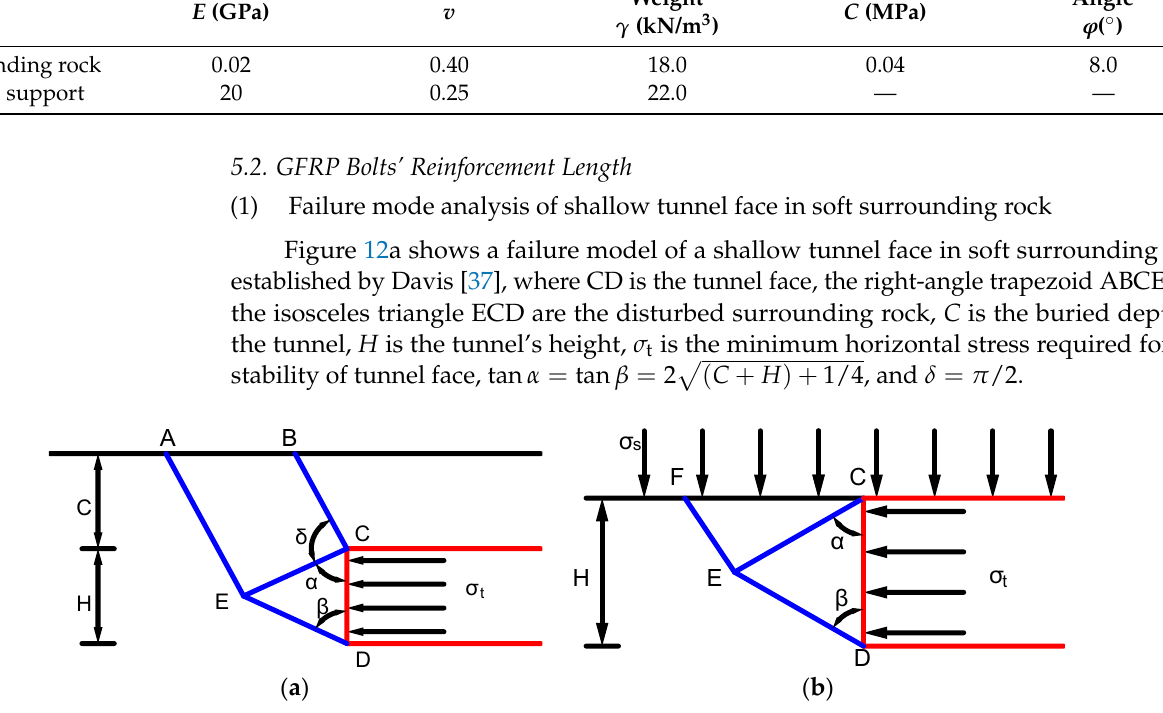
Figure 12. Failure model of shallow tunnel face in soft surrounding rock. ( a ) Failure mode diagram. ( b ) Simplified failure mode diagram.